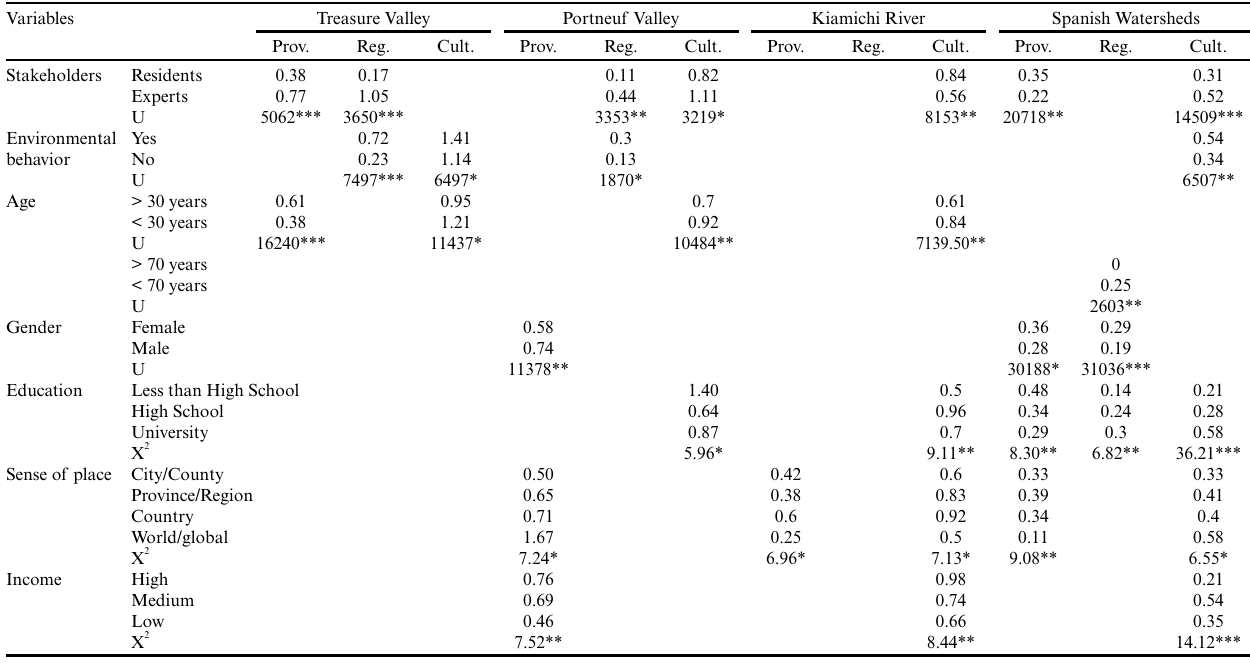
Table 4. Mean relative value based on the number of examples of ecosystem services listed by respondents and grouped by categories, and the factors influencing those people’s perceptions of different services categories. Statistically significant results are shown for the stakeholder type, environmental behavior, age, and gender (Mann-Whitney U test) and for education level, sense of place, and level of income (Kruskal-Wallis test). Statistical significance at the * < 0.1, ** < 0.05, *** < 0.001 levels. Prov. = Provisioning services, Reg. = Regulating services, Cult. = Cultural